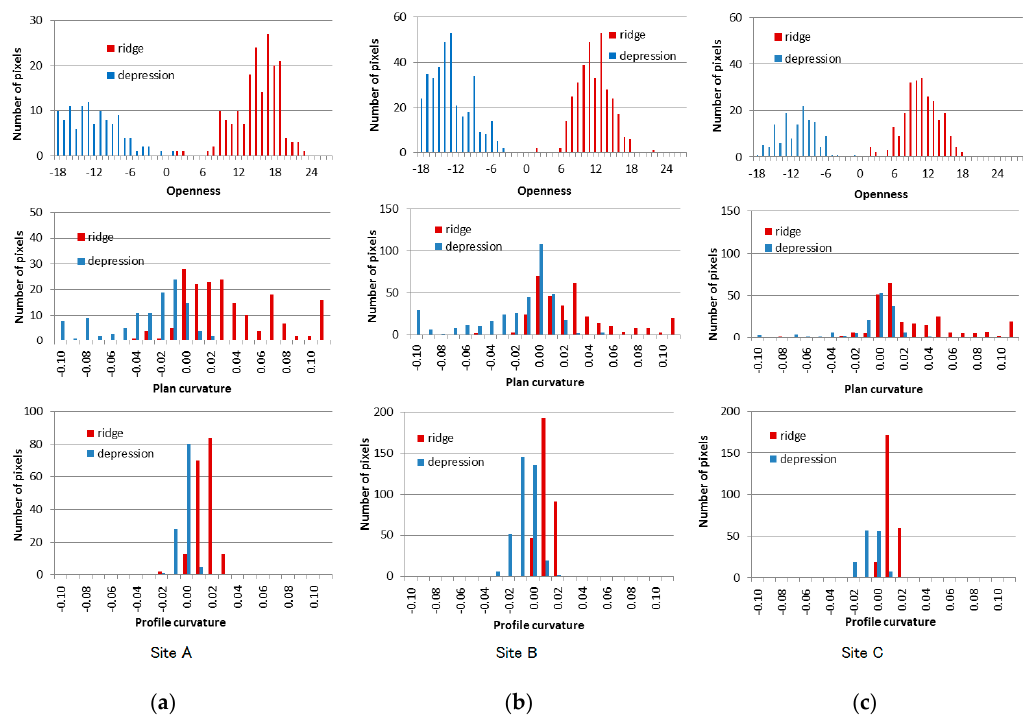
Figure 4. Histograms of topographic parameters openness (top), plan curvature (middle), and profile curvature (bottom) at ( a ) Site A, ( b ) Site B ( b ), and ( c ) Site C.